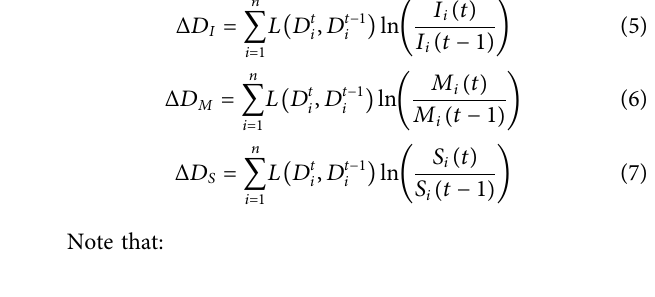
Frontiers in Environmental Science |